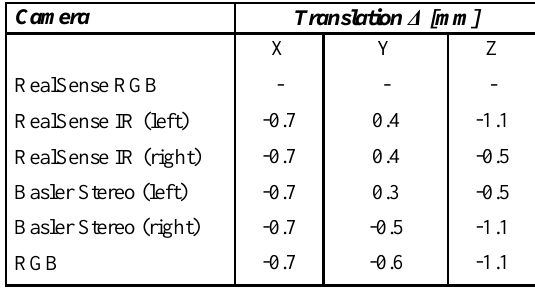
Table 5: Translation differences of sensor pose comparison between two multi-camera calibration runs.